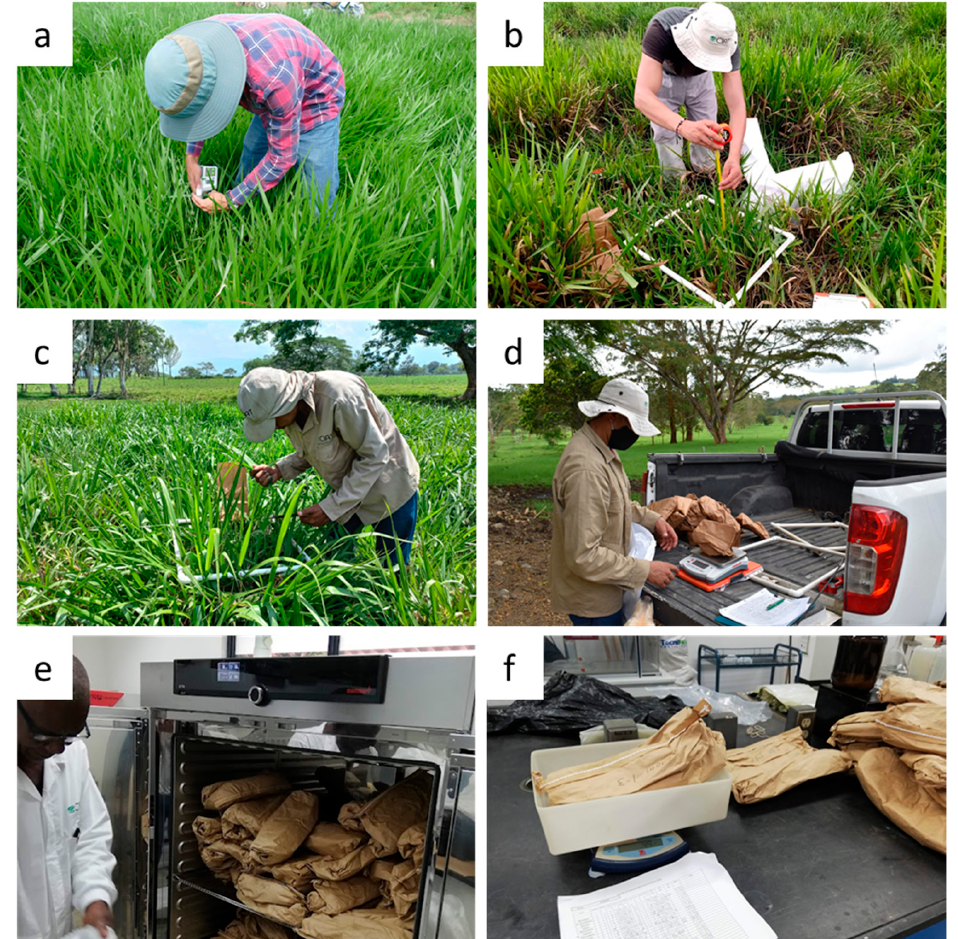
Table 1. GTD variables and the equipment used for data collection.